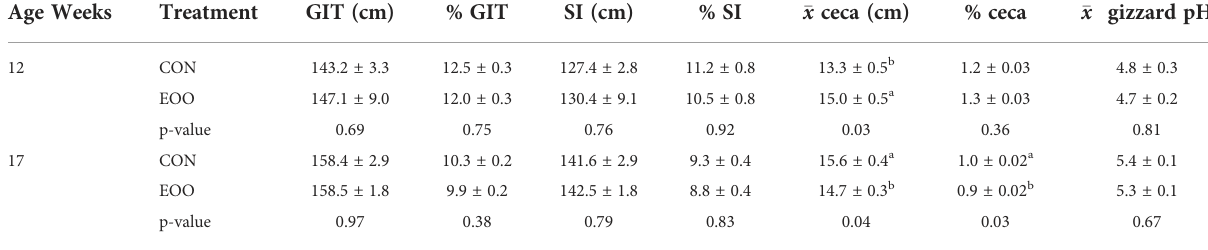
TABLE 5 Gastrointestinal traits of pullets ’ organ lengths at 12 and 17 weeks of age.